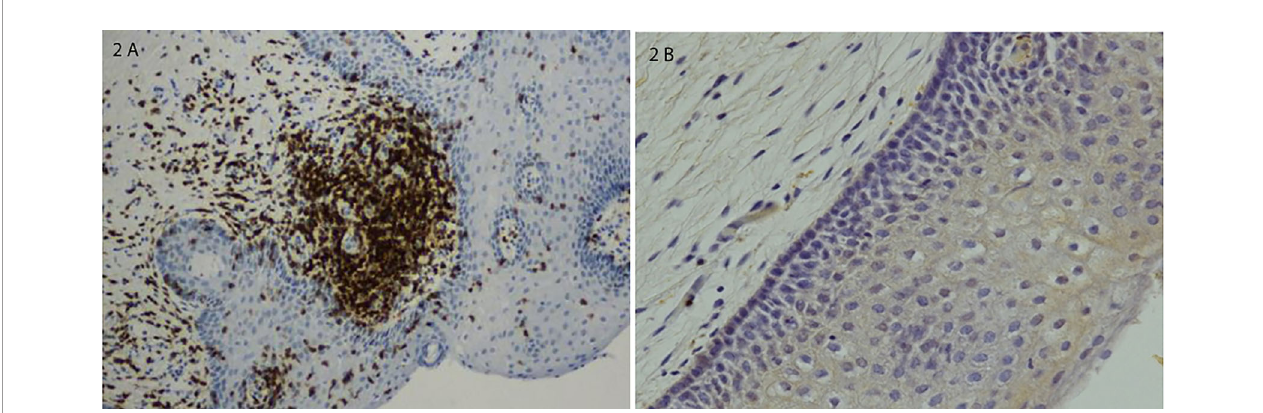
FIGURE 2 | (A) Lymphoid aggregate in a vestibular biopsy from a patient with severe LPV; immunostaining for T cells and B cells. (B) Normal vestibular epithelium without in fl ammatory changes. Histological sections were counterstained with hematoxylin and photomicrographed using x10 objective. Adapted from Tommola P., et al., Am J Obstet Gynecol7; 2015;212(4):476.e1-8 (by